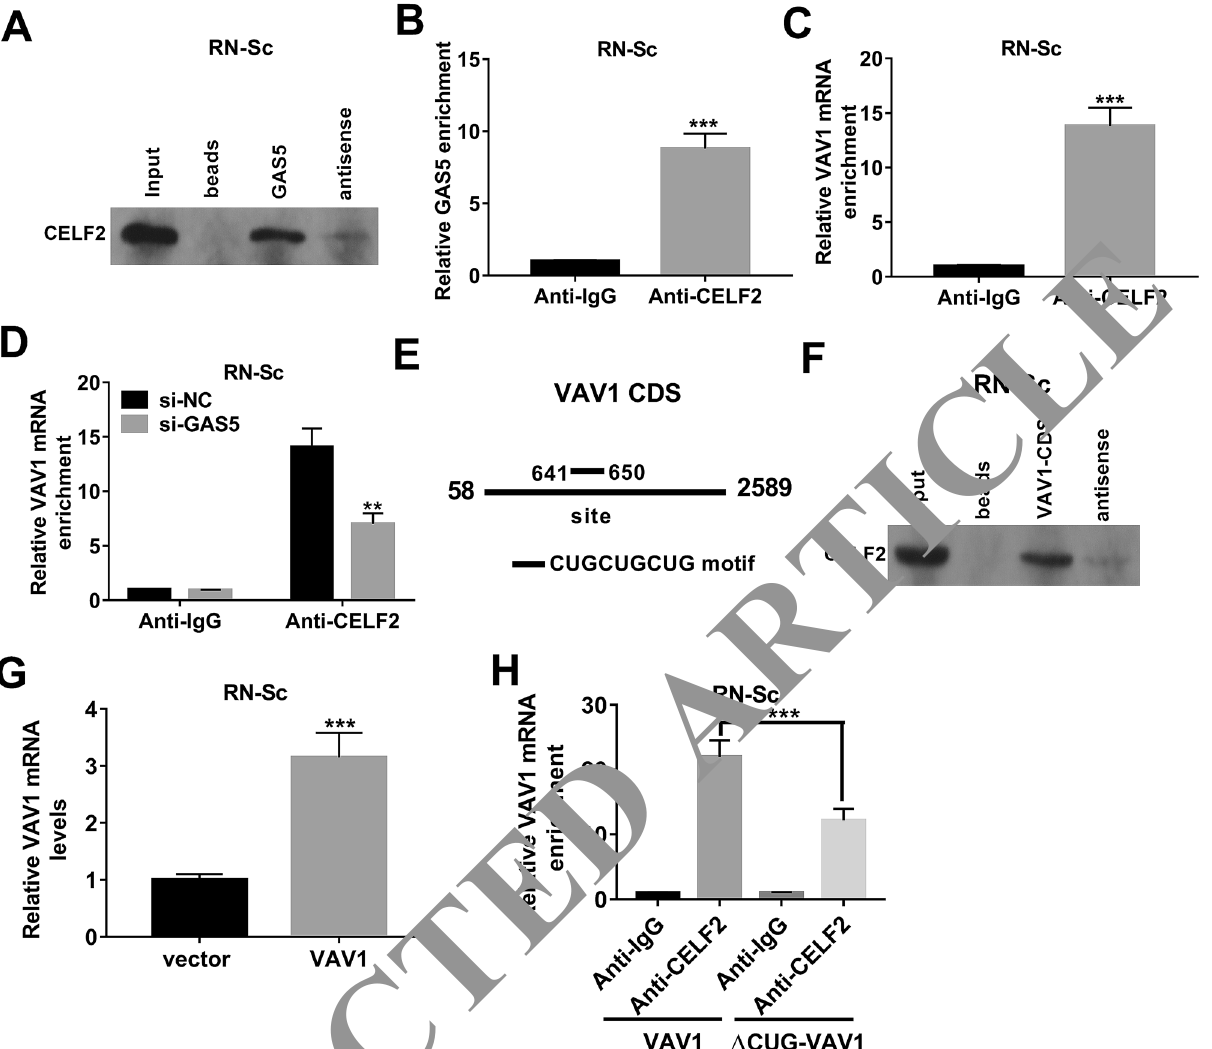
Figure 3. GAS5 recruited CELF2 to VAV1 CDS region. ( A ) CELF2 protein level enriched by biotin-labelled sense or antisense GAS5 sequence was measured by RNA pull down assay coupled with western blot assay. ( B , C ) RIP assay was performed in RN-Sc cells using CELF2 or IgG antibody. Next, GAS5 or VAV1 mRNA level enriched by CELF2 or IgG antibody was measured by RT-qPCR assay. ( D ) RN-Sc cells were transfected with si-NC or si-GAS5. At 48 h post transfection, RIP and RT-qPCR assays were conducted to examine the VAV1 mRNA level enriched by CELF2 or IgG antibody. ( E ) Putative binding sites between CELF2 protein and VAV1 CDS. ( F ) CELF2 protein level pulled down by biotin-labelled sense or antisense VAV1 CDS sequence was measured by RNA pull down assay coupled with western blot assay. ( G ) RN-Sc cells were transfected with empty vector or VAV1 overexpression plasmid, followed by the detection of VAV1 mRNA level at 48 h post transfection. ( H ) RN-Sc cells were transfected with VAV1 overexpression plasmid or mutated VAV1